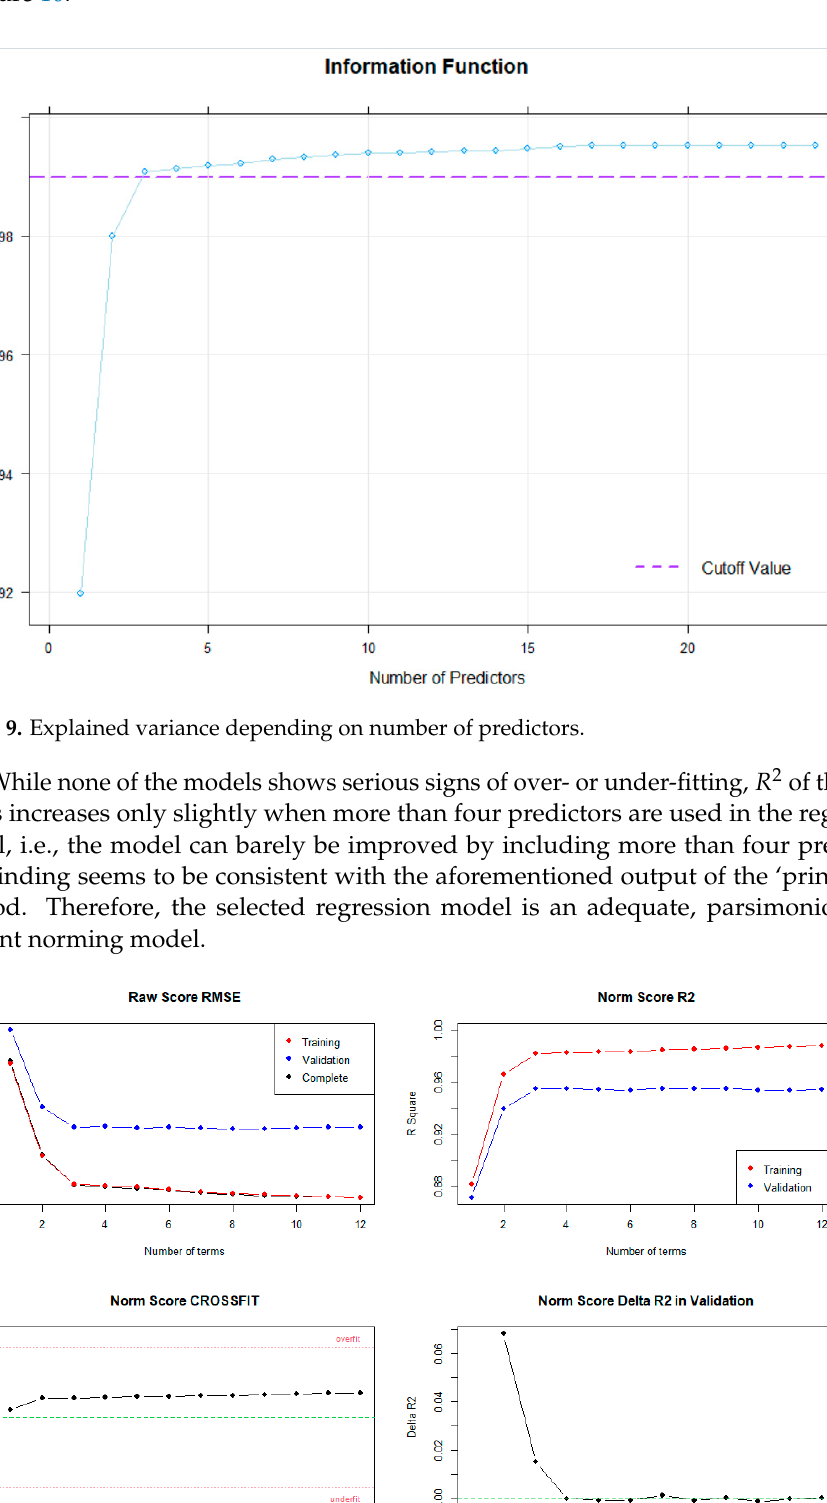
Figure 8. Information criteria for best models.